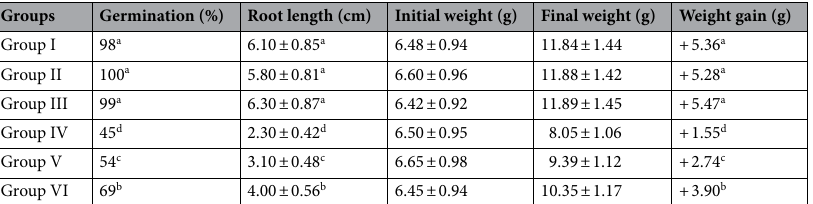
Table 1. Protective role of Bmex against the physiological changes induced by glyphosate. Group I: Control, Group II: 350 mg/L Bmex, Group III: 700 mg/L Bmex, Group IV: 500 mg/L glyphosate, Group V: 500 mg/L glyphosate + 350 mg/L Bmex, Group VI: 500 mg/L glyphosate + 700 mg/L Bmex. Values are shown as mean ± SD. 50 bulbs in each group were used for germination percentage and weight gain. For root length measurements 10 bulbs were used in each group. The averages shown with different letters (a–d) in the same column are significant at p <